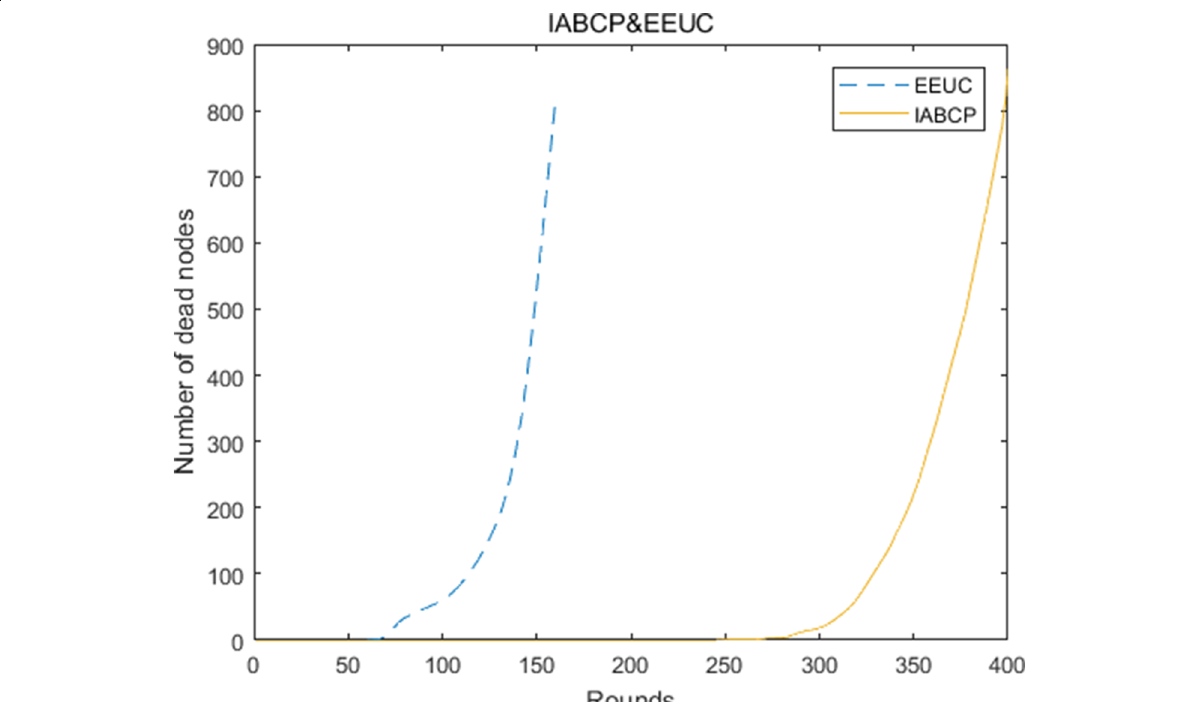
Fig. 9 Curves of the dead number of nodes. It mainly shows the changes of the number of dead nodes in the network during the process of gradually dying until half of the nodes